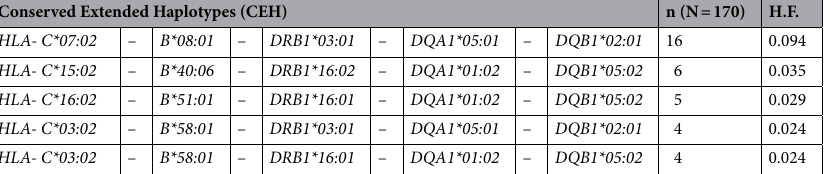
Table 6. MHC conserved extended haplotypes (CEH) derived from 41 UAE families with H.F. > 0.02. H.F.: haplotypes frequency.